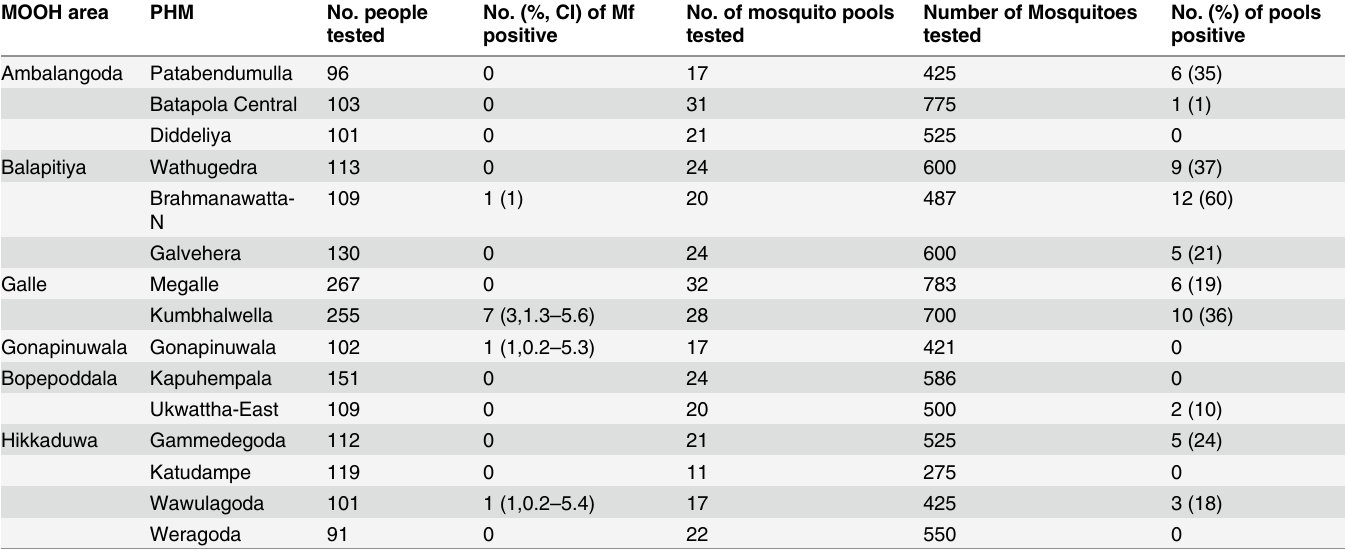
Table 5. Microfilaremia in humans and filarial DNA rates in mosquitoes by Public Health Midwife area in the coastal evaluation unit. MOOH area PHM No. people